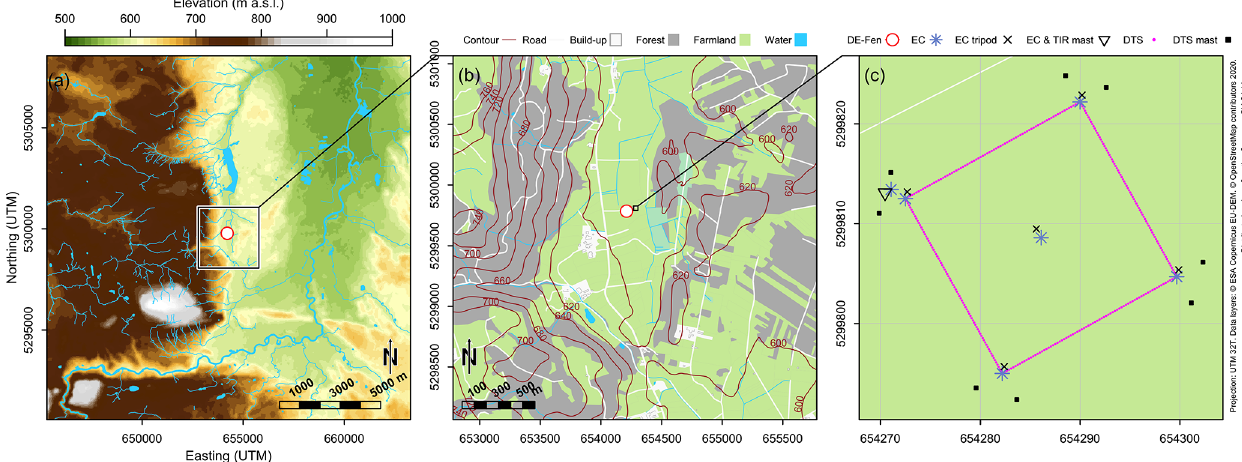
Figure 1. The location of the study site with aspects of (a) topography and runoff, (b) land use and (c) the sensor network setup. Data layers: